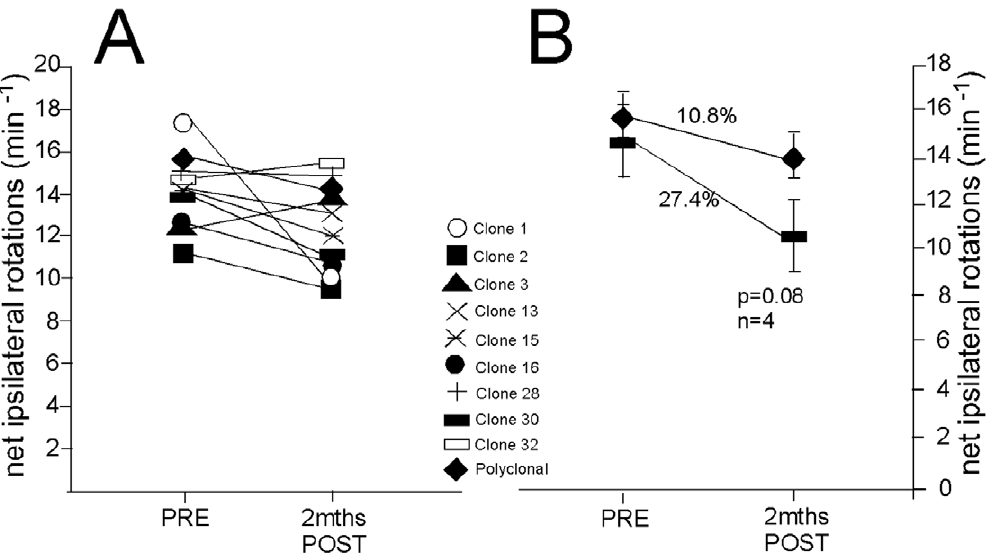
Figure 5. Assessment of drug-induced rotation. A) Amphetamine-induced net ipsilateral rotations before (PRE) and 2 months after transplantation (POST). Note the trend for a partial recovery observed in the majority of animal groups. Since the present work required examination of many clones, the number of animals per group was kept to a minimum (3–5) and thus non-significant trends are observed. B) Clone 30 transplants were twice as effective than the polyclonal hVM1-Bcl-X L cel grafts in inducing rotation